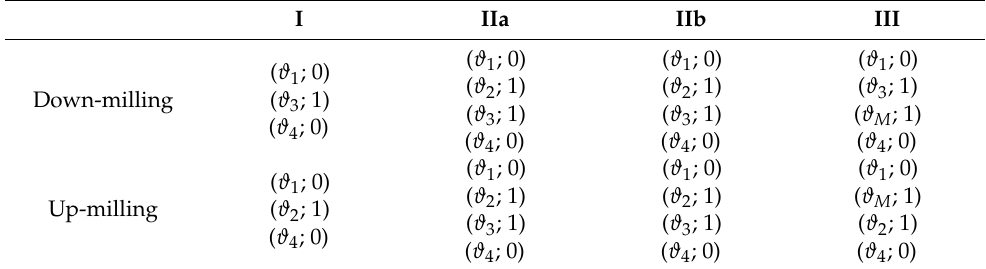
Table 2. Single flute F type key